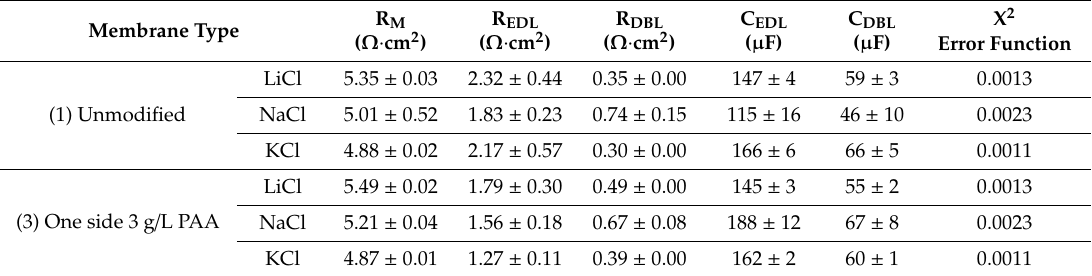
Table 6. EIS results via equivalent circuit model tool in 0.5 M NaCl, 0.5 M KCl, and 0.5 M LiCl aqueous